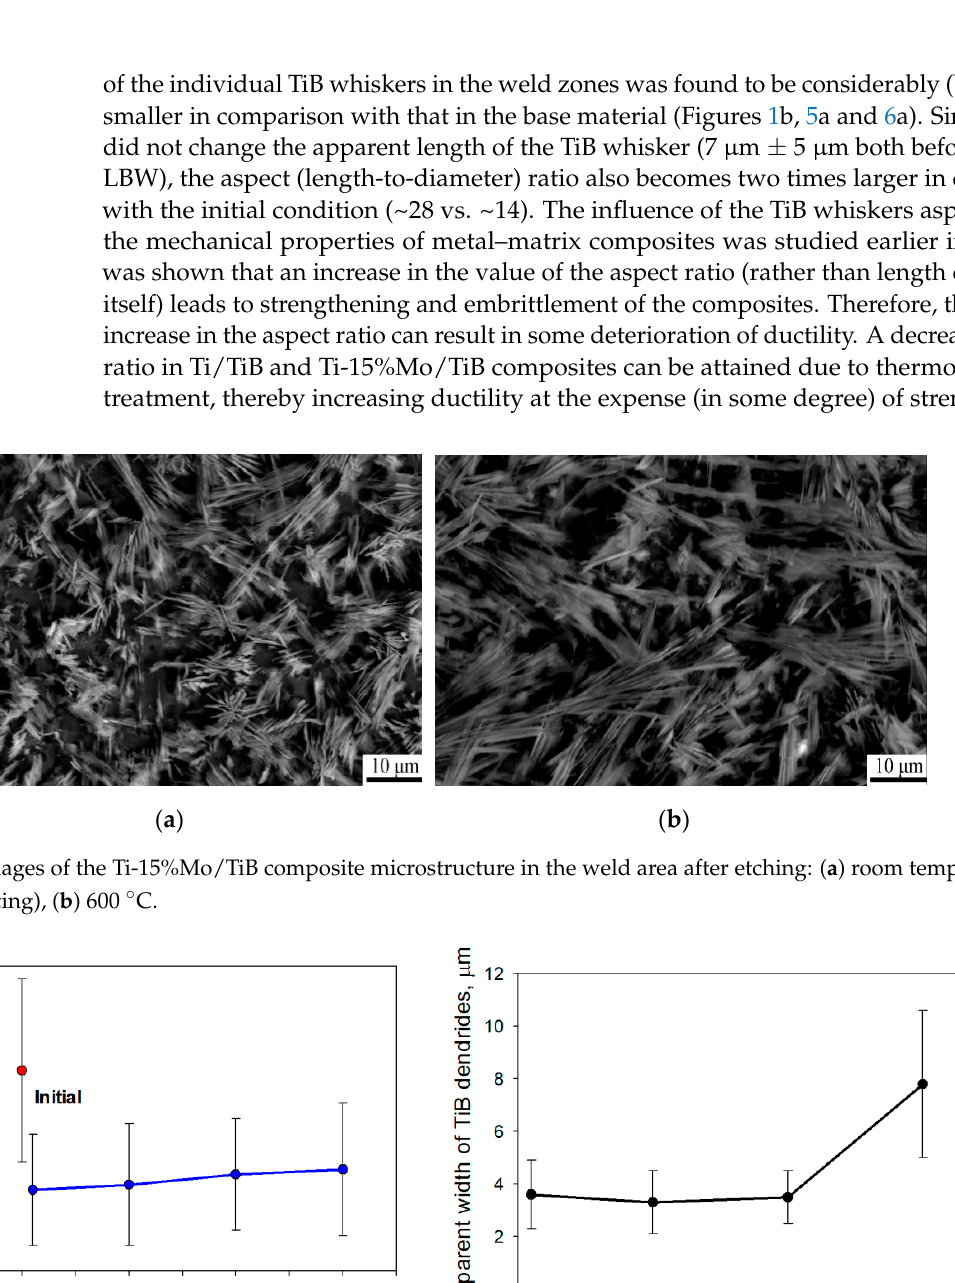
( d ) Figure 4. SEM images of the Ti-15%Mo/TiB composite microstructure at the border between the